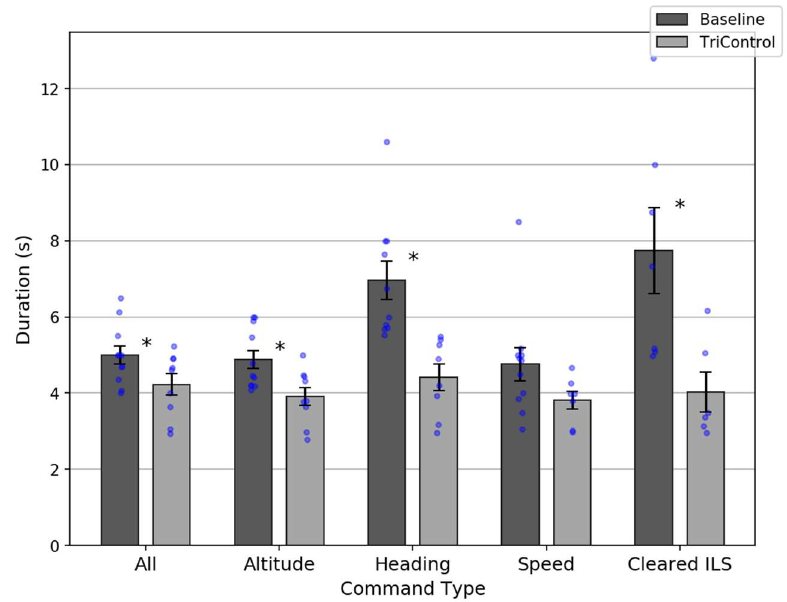
Figure 7. Baseline unchained commands vs. TriControl second half uncorrected German-speaker command duration. Error bars represent ±1 standard error of the mean. Blue dots represent individual controllers.